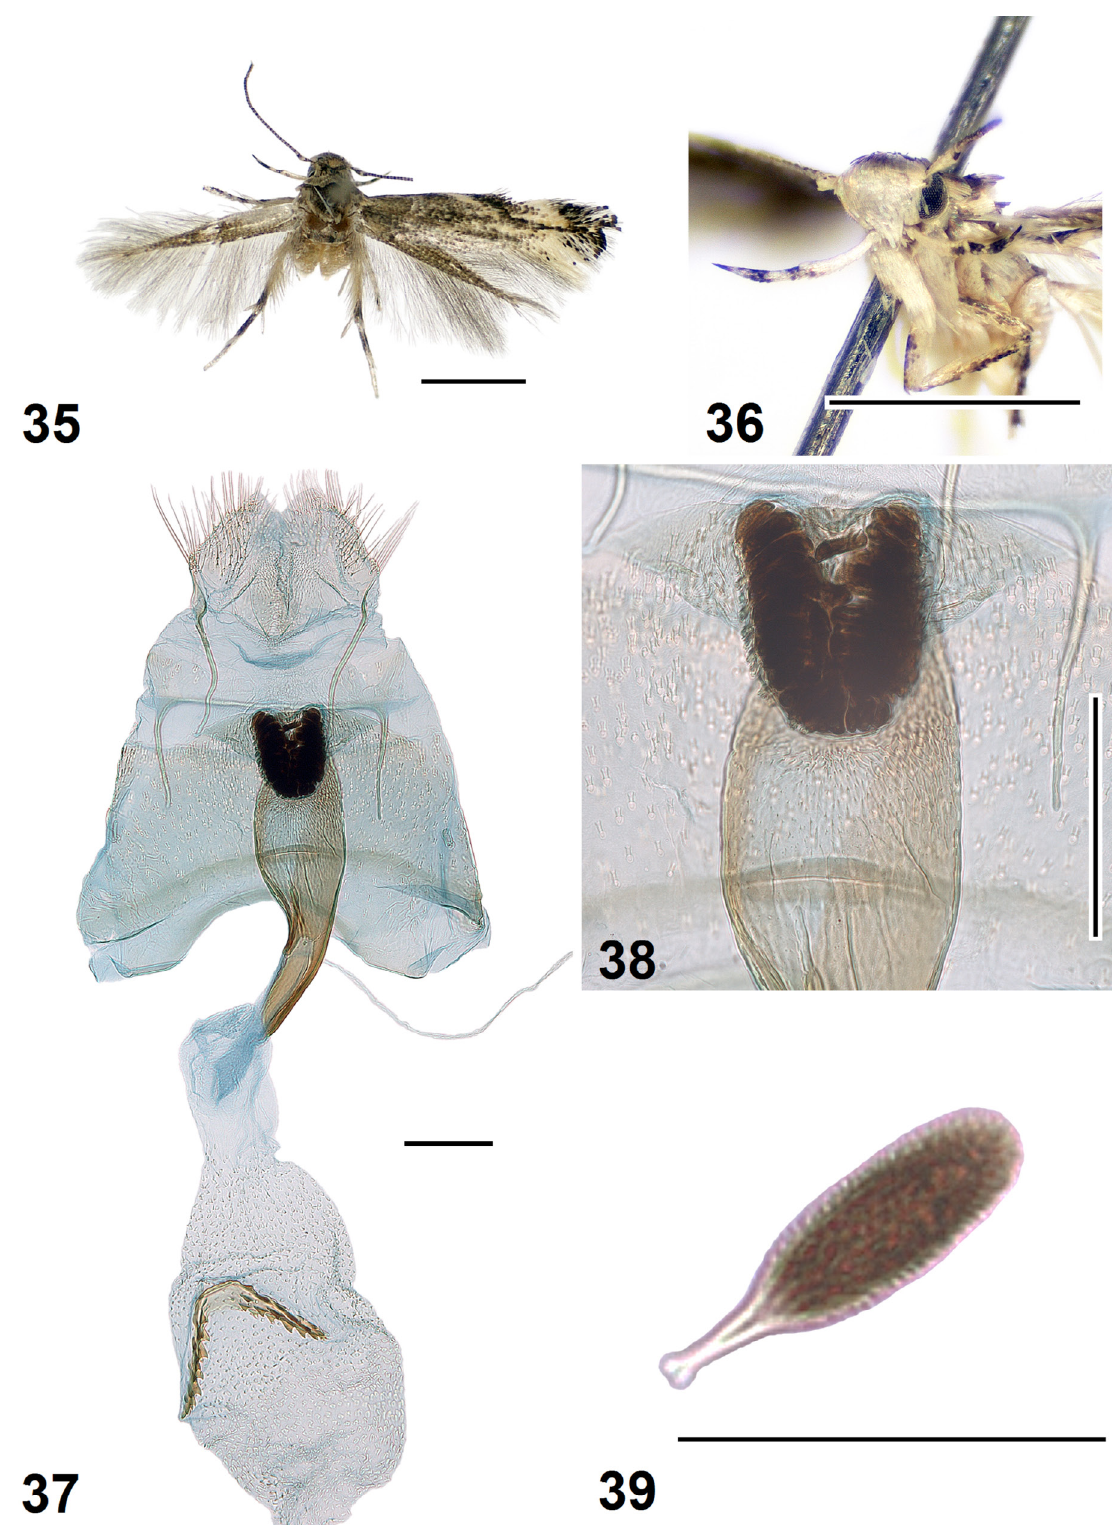
Figs 35–39. Elachista pellineni Sruoga & Kaila sp. nov., paratype, ♀ (MZH VS1/24.11.18). 35 . Adult. 36 . Head, latero-frontal view. 37 . Female genitalia. 38 . Antrum. 39 . Scale from antrum. Scale bars: 35–36 = 1 mm; 37–38 = 0.1 mm; 39 = 0.03